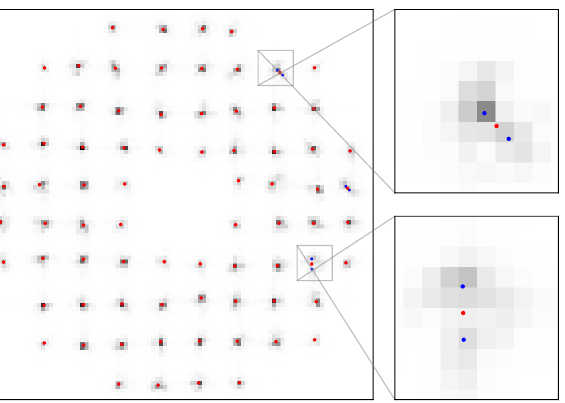
Figure 11. All the detected centroids (blue) and average ones for each sub-apertures (red) are annotated on the SHWFS spots pattern (invalid sub-apertures are not shown here). Color for the spots is inverted for better